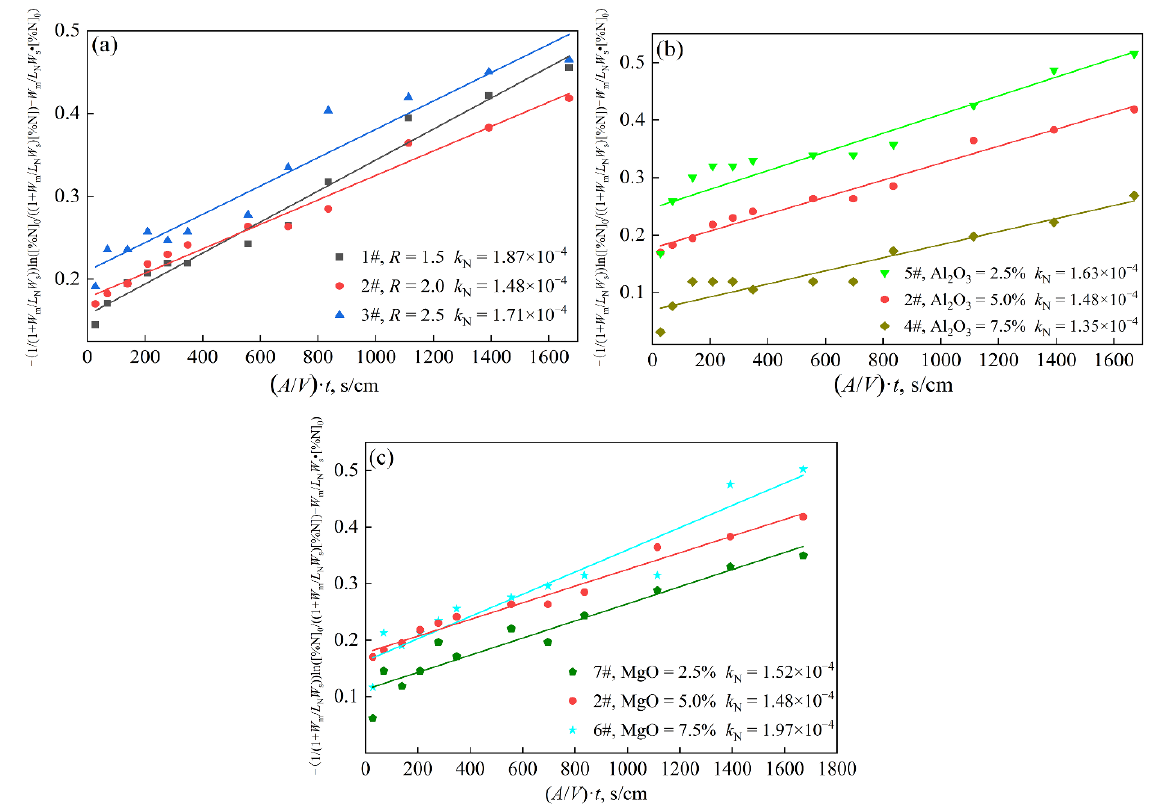
Figure 9. Fitting of the kinetic model and experimental results ( a ) Different basicity slags; ( b ) Different Al 2 O 3 content slags; ( c ) Different MgO content slags.